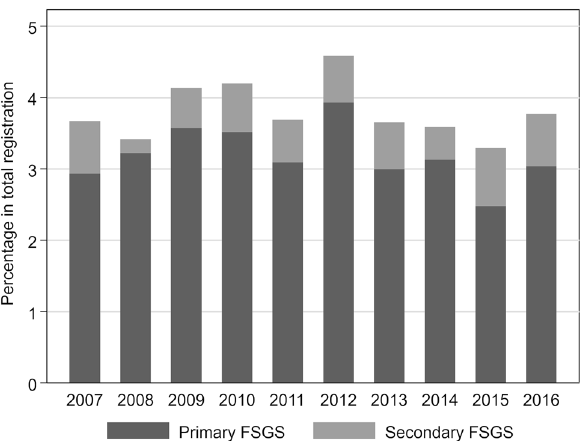
Figure 2. Annual incidence of FSGS in the J-RBR. J-RBR Japan Renal Biopsy Registry, FSGS focal segmental